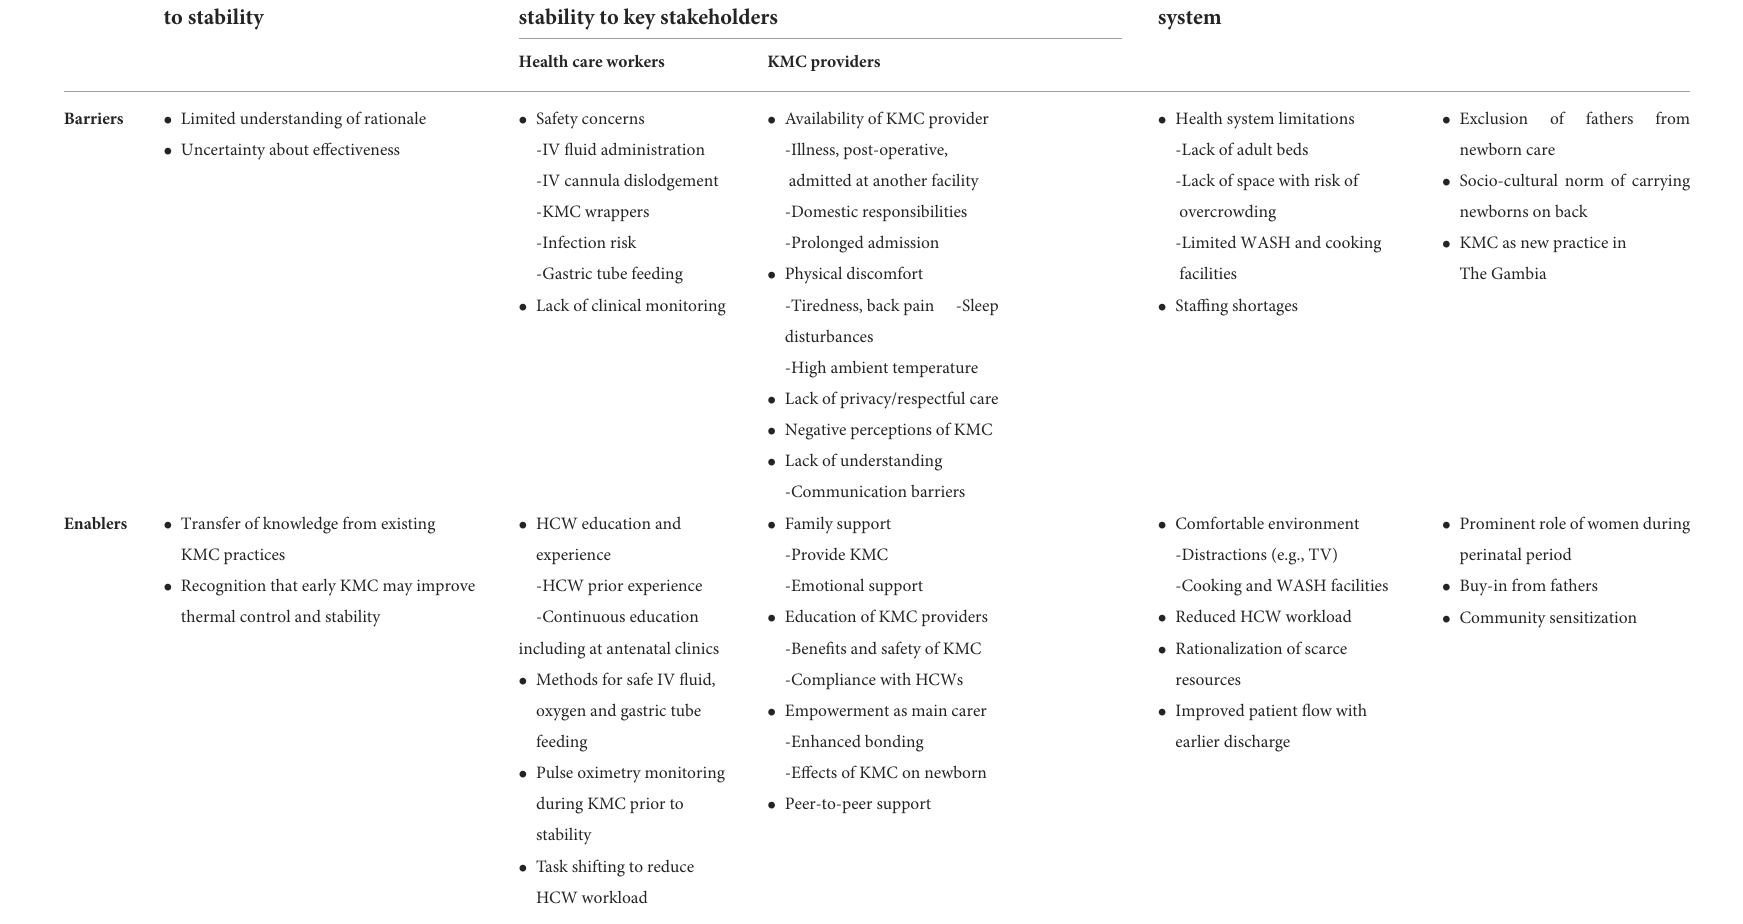
TABLE 2 Barriers and enablers for delivery of KMC prior to stability, as perceived by Gambian health care